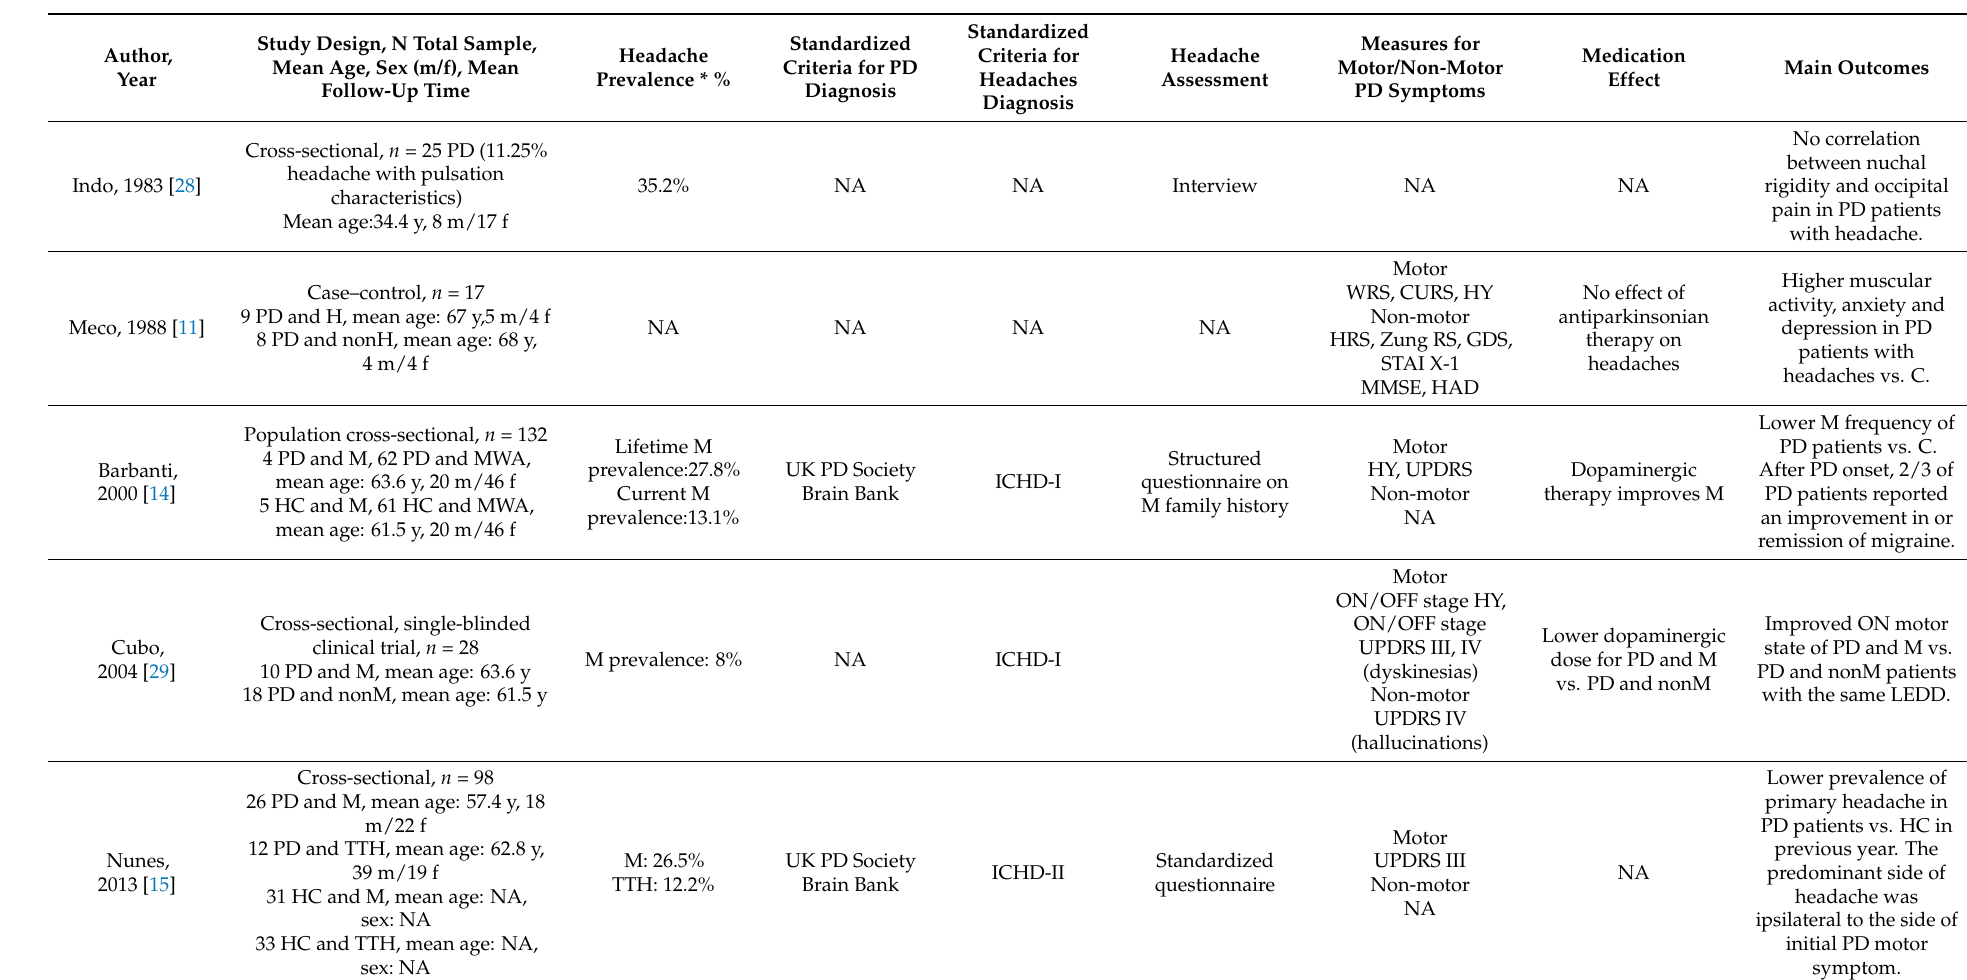
Table 1. Summary of main characteristics and outcomes of patients with PD and migraine or